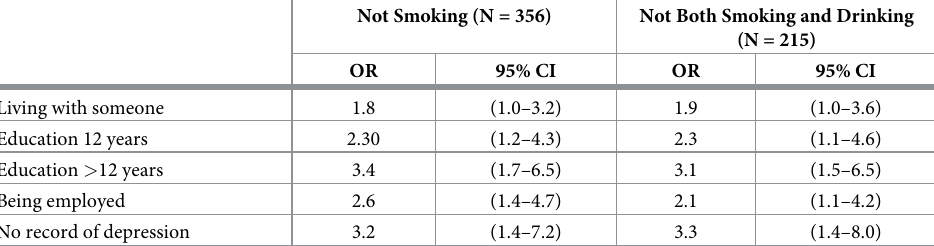
Table 2. Logistic regression for not smoking or not both smoking and